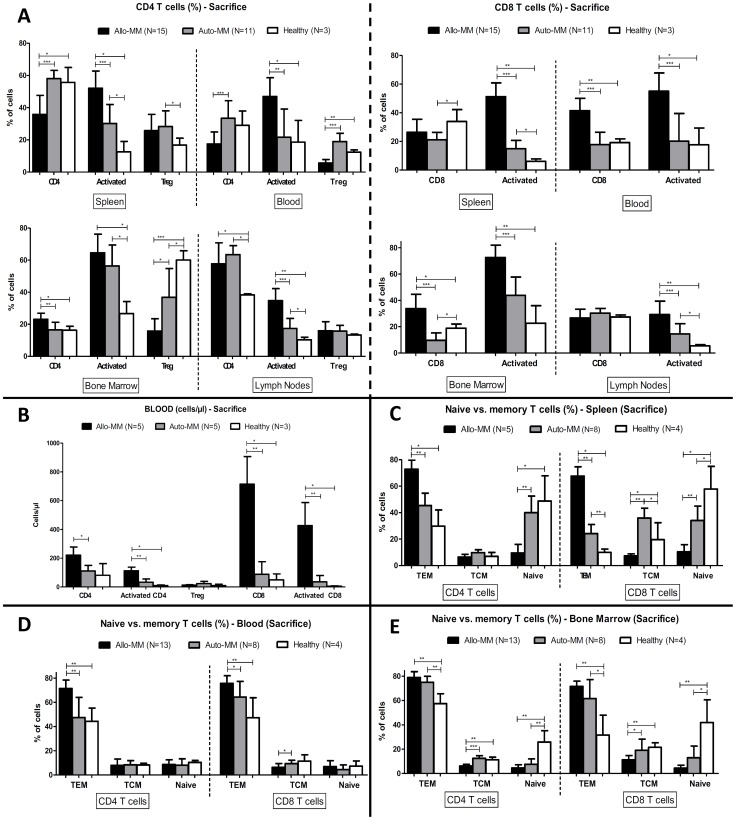
T-cell populations in graft-versus-myeloma model.Flow cytometry staining was performed for T cells on blood and lymphoid organs (spleen, bone marrow, lymph nodes) at sacrifice. (A) On the left, percentages (mean±SD) of CD4 T cells (within CD3+), activated CD4 T cells (CD69+ within CD4+) and regulatory T cells (Foxp3+ within CD4+) and, on the right, percentages of CD8 T cells (within CD3+) or activated CD8 cells (CD69+ within CD8+) in the Allo-MM or Auto-MM group, or in healthy Balb/cJ mice. *p<0.05; **p<0.01; ***p<0.001 (Mann-Whitney test). (B) T-cell quantitation in blood. Absolute cell numbers (mean±SD) per µl of blood at sacrifice are represented for CD4, activated CD4, regulatory CD4, CD8 and activated CD8 T cells in the Allo-MM or Auto-MM group, or in healthy Balb/cJ mice. *p<0.05; **p<0.01; ***p<0.001 (Mann-Whitney test). Naive vs. memory T-cell subsets in spleen (C), blood (D) and bone marrow (E). Percentages (mean±SD) of effector memory T cells (TEM, CD44+CD62L−), central memory T cells (TCM, CD44+CD62L+) and naive T cells (CD44−CD62L+) within CD4 or CD8 T cells at sacrifice are represented. *p<0.05; **p<0.01; ***p<0.001 (Mann-Whitney test).